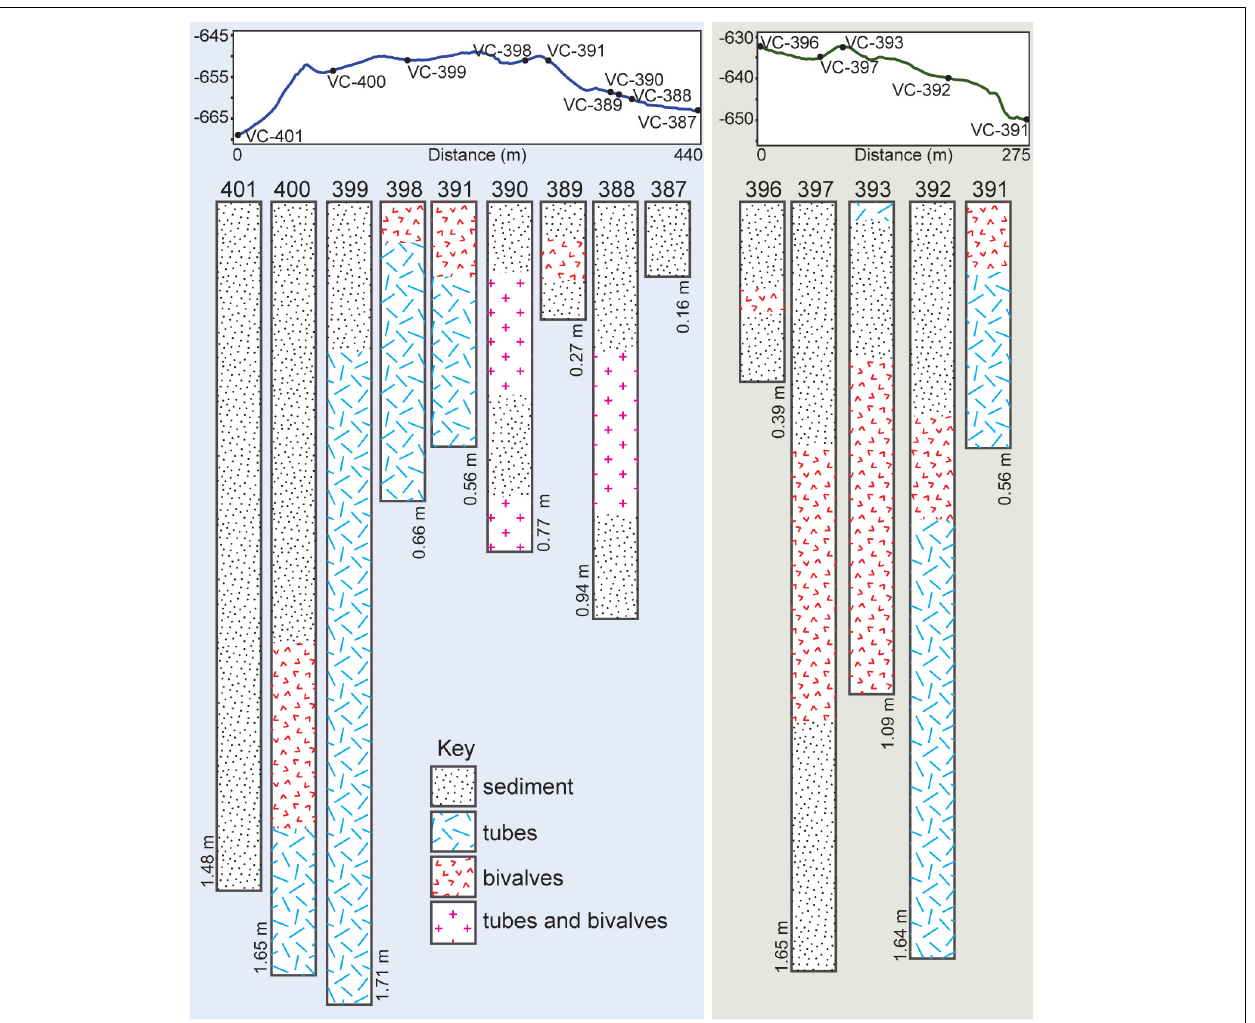
FIGURE 6 | Elevation profiles through parts of Fossil Hill along which vibracores were collected, and contents of cores (78 mm diameter) collected along the above profiles. Annotations on cores show core depths in meters, and sediment refers to fine-grained hemipelagic sediment. Tracks along which elevation profiles were created are illustrated in Figure 1C